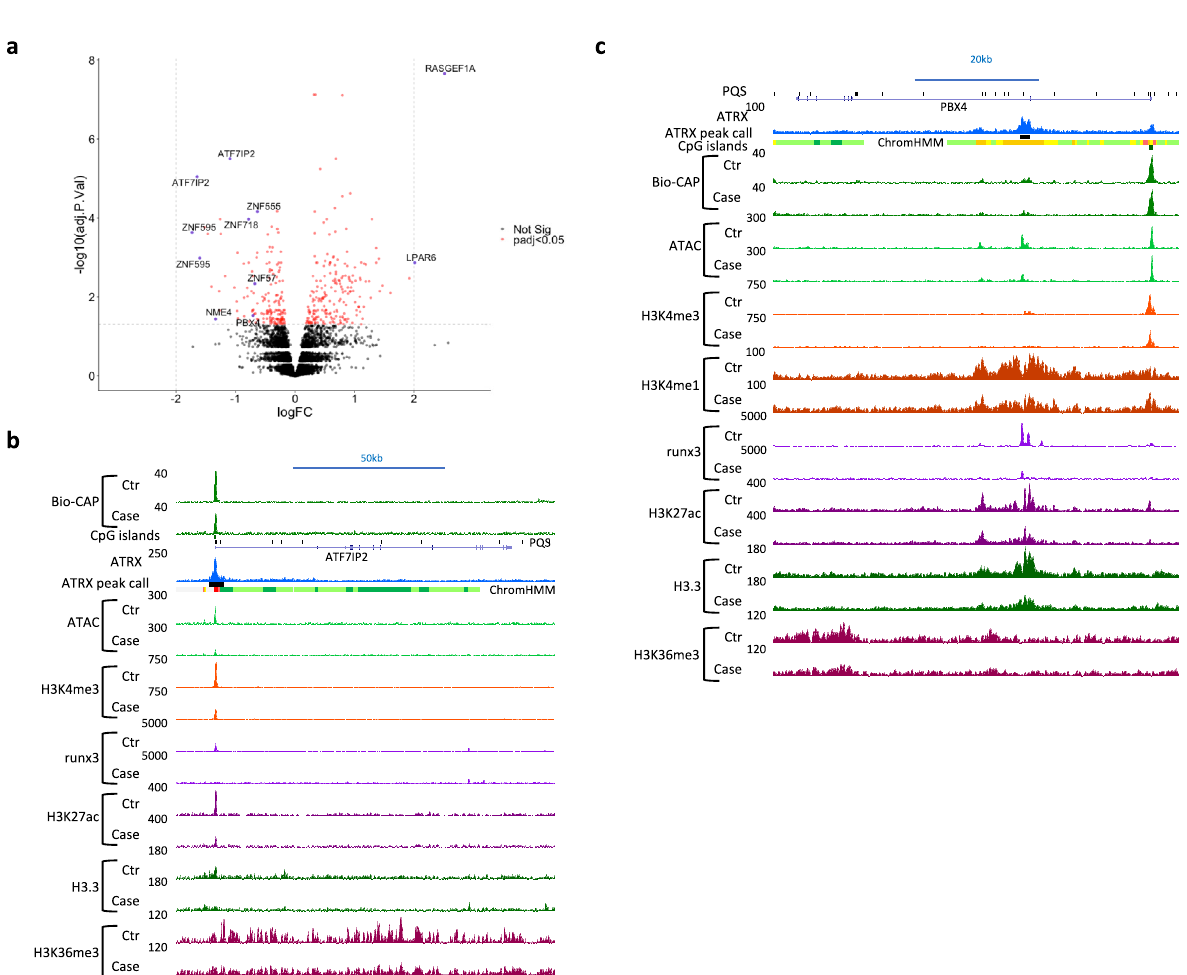
Fig. 4 Pathogenic ATRX mutations are associated with changes in chromatin environment at regulatory elements in LCLs. a Volcano plot of the microarray data comparing LCLs derived from ATR-X cases and unaffected donors. In red (or blue if highlighted with gene name), the probes that are signi fi cantly differentially expressed (ATR-X cases relative to controls) with an adjusted p -value ≤ 0.05 (horizontal grey dot line). adj. P .Val = adjusted p - values based on lmFit and eBayes (empirical Bayes moderated t -statistics test) from the limma packages 39 and adjustment with Benjamini Hochberg. Adjusted p -values for probes highlighted in blue: ATF7IP2 (adj. P .Val = 9.14E − 06 and 3.19E − 06), LPAR6 (adj. P .Val = 1.37E − 03), NME4 (adj. P .Val = 3.67E − 02), PBX4 (adj. P .Val = 2.96E − 02), RASGEF1A (adj. P .Val = 2.22E − 08), ZNF555 (adj. P .Val = 6.96E − 05), ZNF57 (adj. P .Val = 4.65E − 03), ZNF595 (adj. P .Val = 2.36E − 04 and 1.05E − 03) and ZNF718 (adj. P .Val = 1.08E − 04). logFC = log fold change of cases over controls ( n = 20 for the controls and n = 28 for the cases). b ATF7IP2 locus. c PBX4 locus. Signals of chromatin marks, Bio-CAP, ATAC, and Runx3, for ATR-X individuals (Case) and controls (Ctr). The signals represent an average of the independent replicates ( n = 3 except for ATAC ( n = 4) and H3K27ac and runx3 ( n = 2) and ATRX ( n =